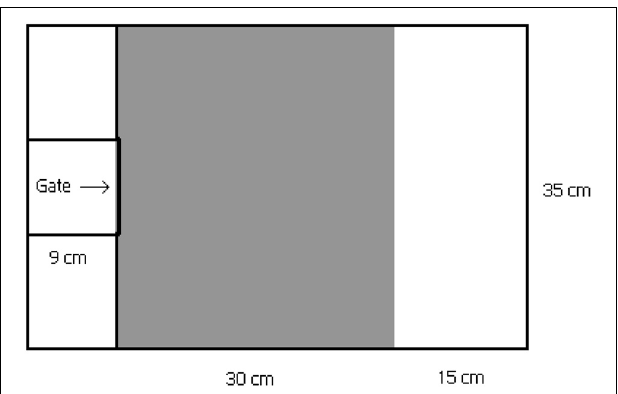
FIGURE 1 | Test arena for the behavioral experiments. Test arena consist three parts: 1. small acclimation area (in the left) with roll-up gate for acclimation period, 2. gray-colored section (in the middle) and 3. white-colored section (in the right). White-colored section is expected to represent more risky environment for the minnows than gray-colored